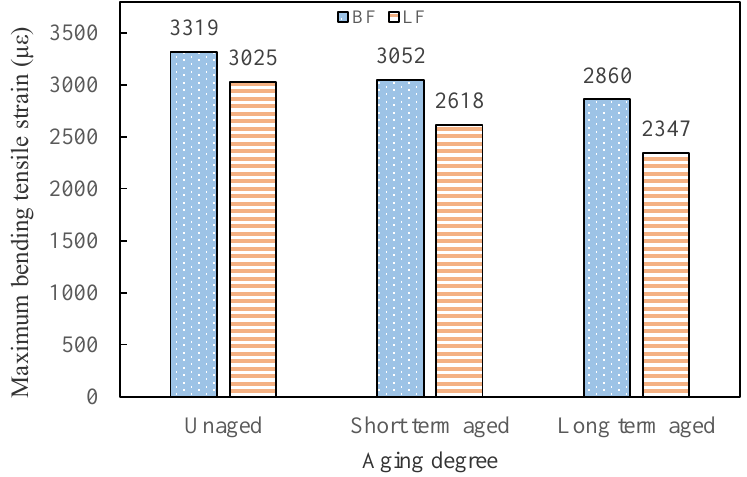
Figure 6. Maximum bending tensile strain.